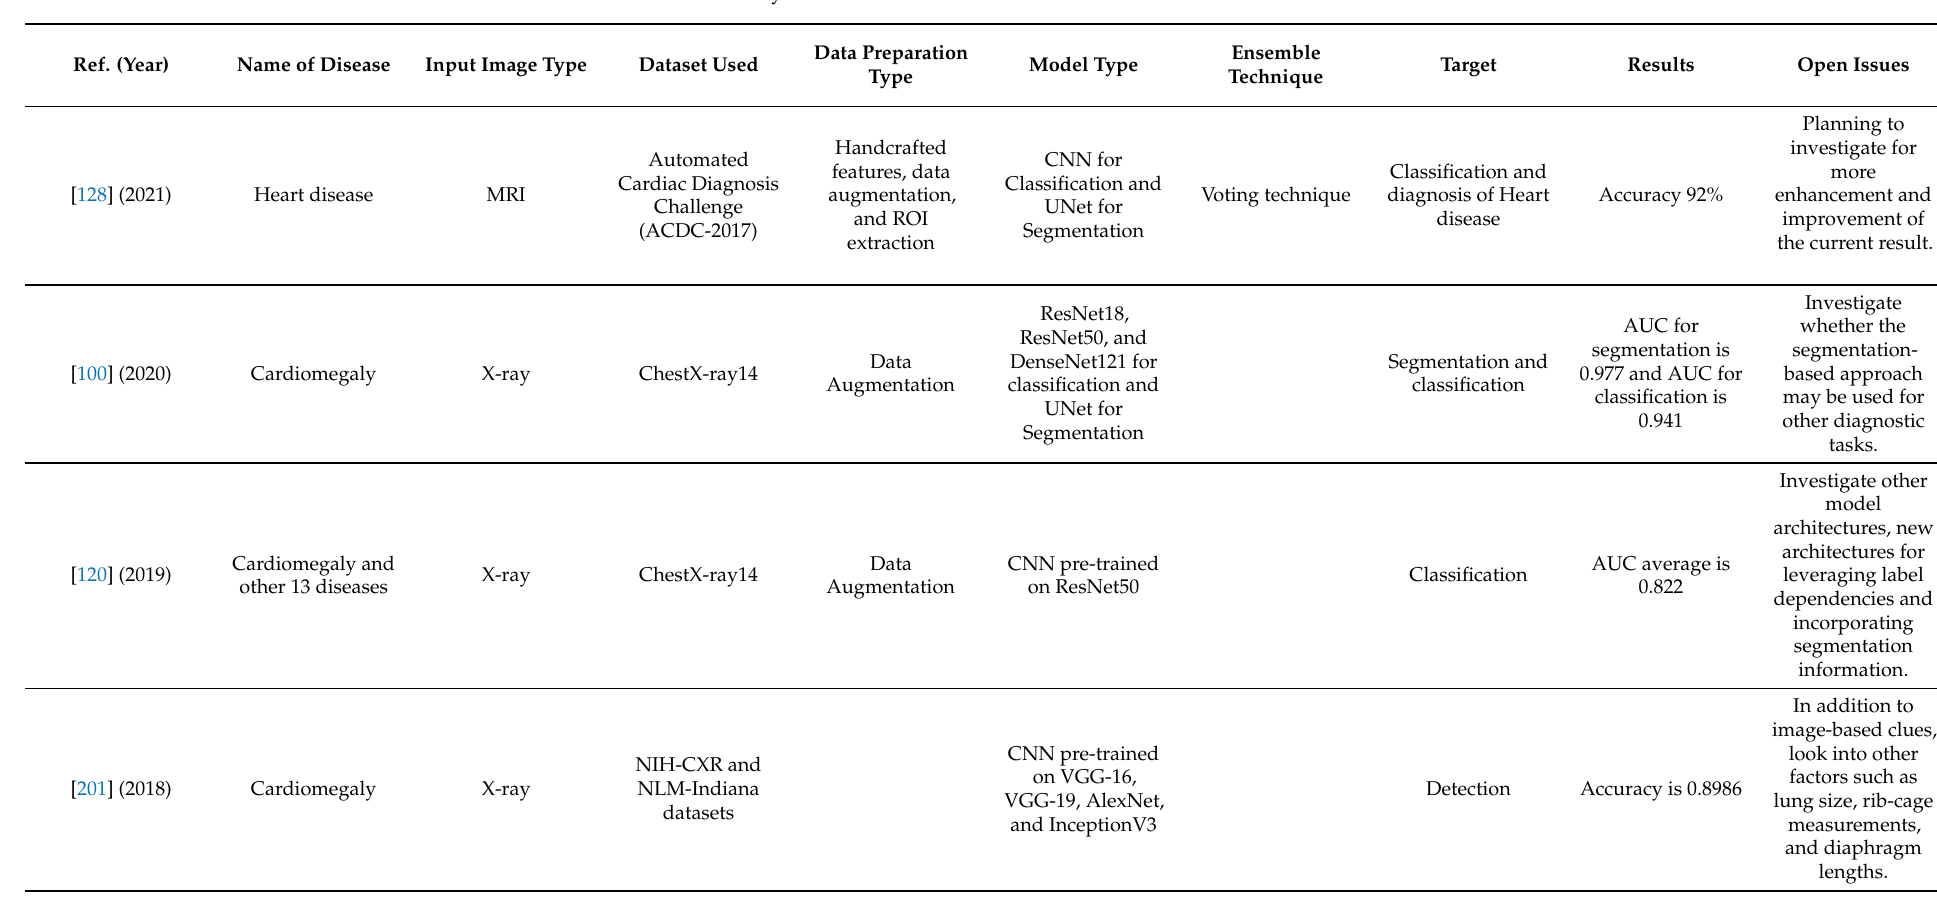
Table 6. Heart diseases’ detection